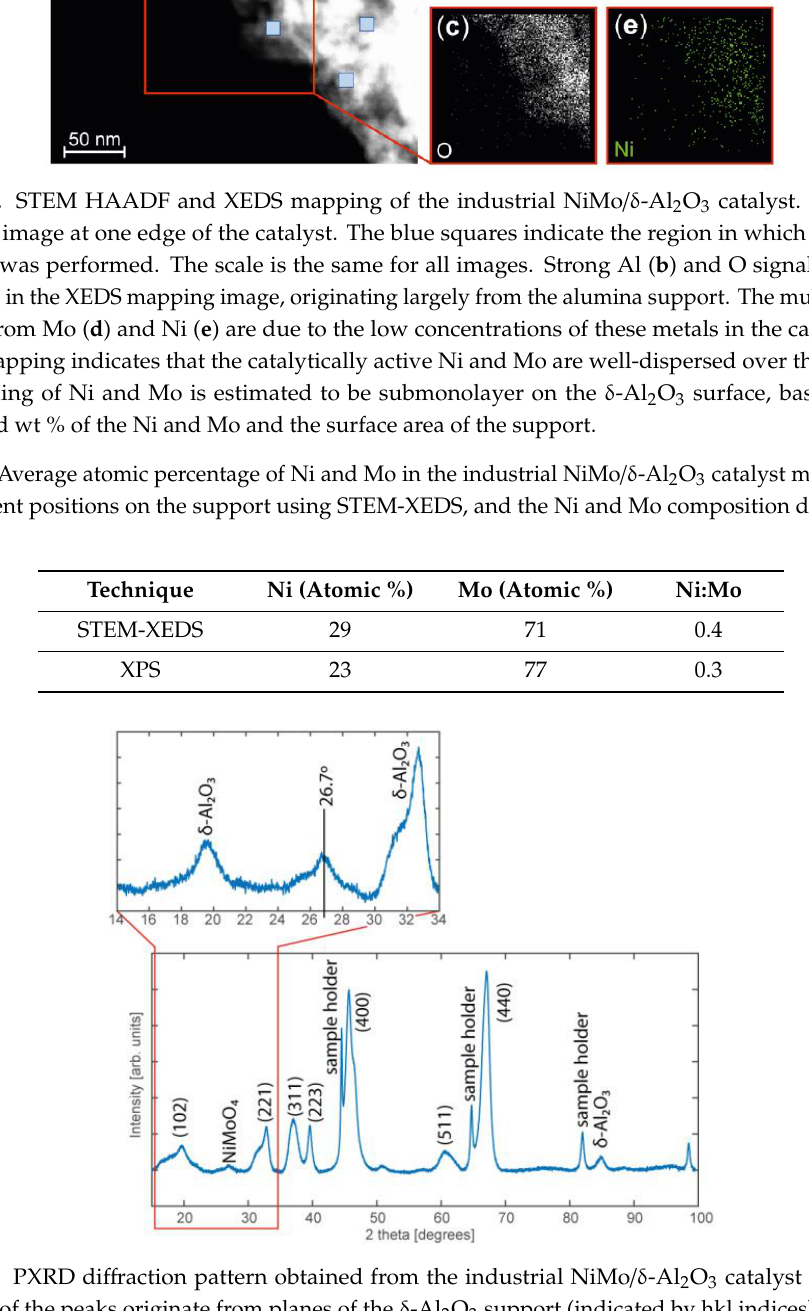
Figure 5. PXRD di ff raction pattern obtained from the industrial NiMo / δ -Al 2 O 3 catalyst where the Figure 5. PXRD diffraction pattern obtained from the industrial NiMo/δ-Al 2 O 3 catalyst where the majority of the peaks originate from planes of the δ -Al 2 O 3 support (indicated by hkl indices). A broad, majority of the peaks originate from planes of the δ-Al 2 O 3 support (indicated by hkl indices). A broad, weak di ff raction peak is, however, also visible at 26.7 ◦ which corresponds to the NiMoO 4 weak diffraction peak is, however, also visible at 26.7 °which corresponds to the NiMoO 4 structure.